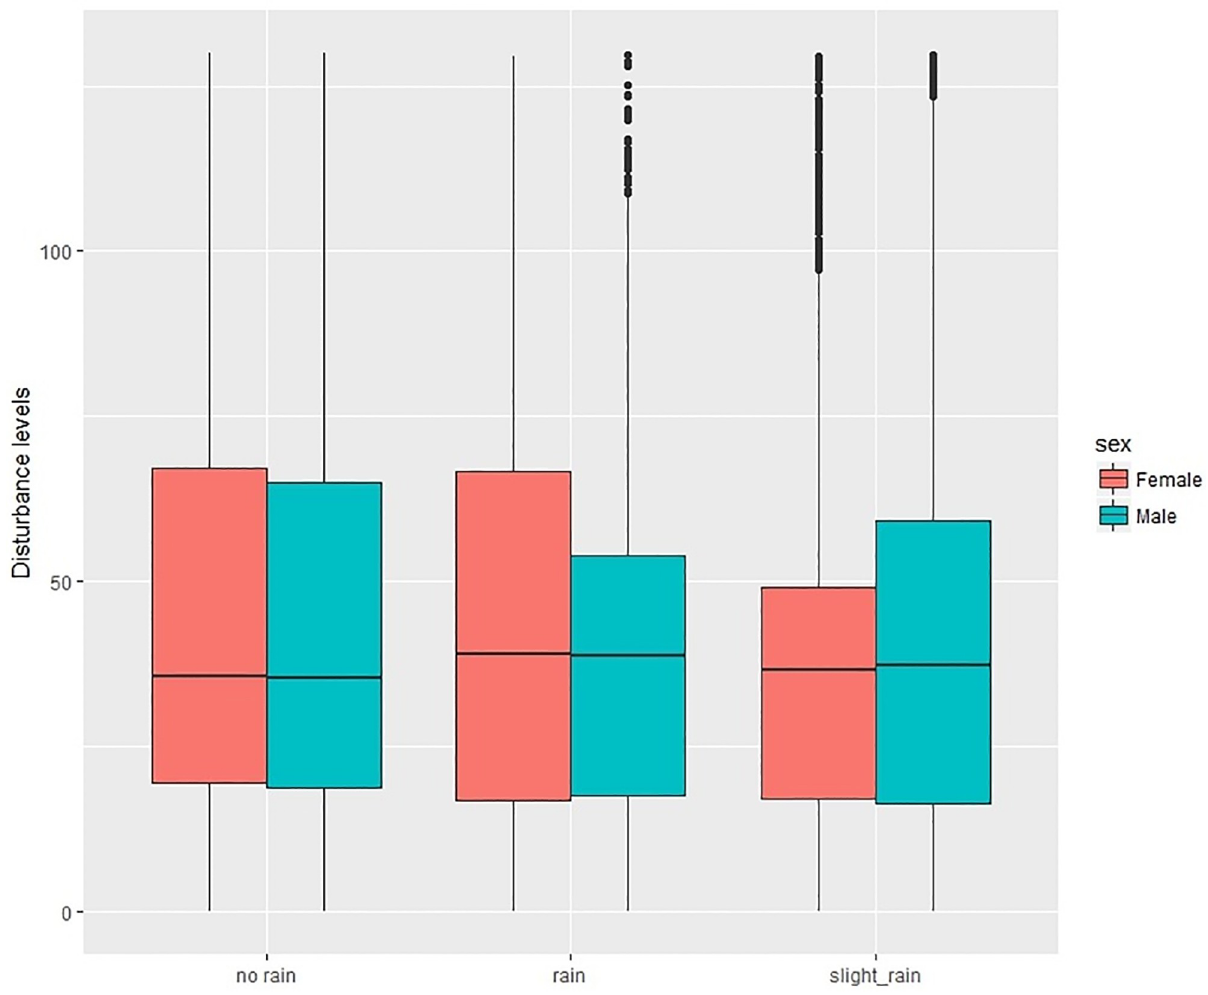
Fig 14. Individual disturbance for men and women in according to the weather